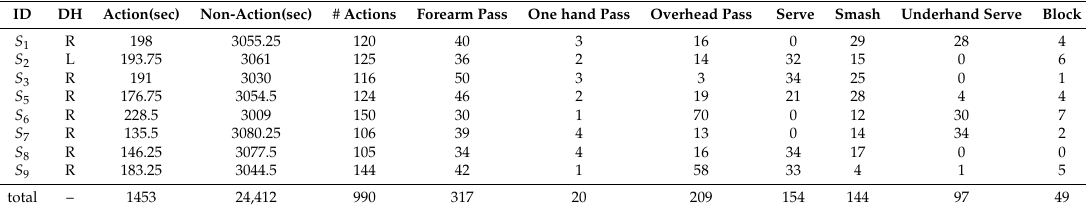
Table 1. Data Set Description: Time taken by each player (ID) to perform actions and non-actions, number and type of actions performed by each player (ID) and Dominant Hand (DH; Right(R) or Left(L) )